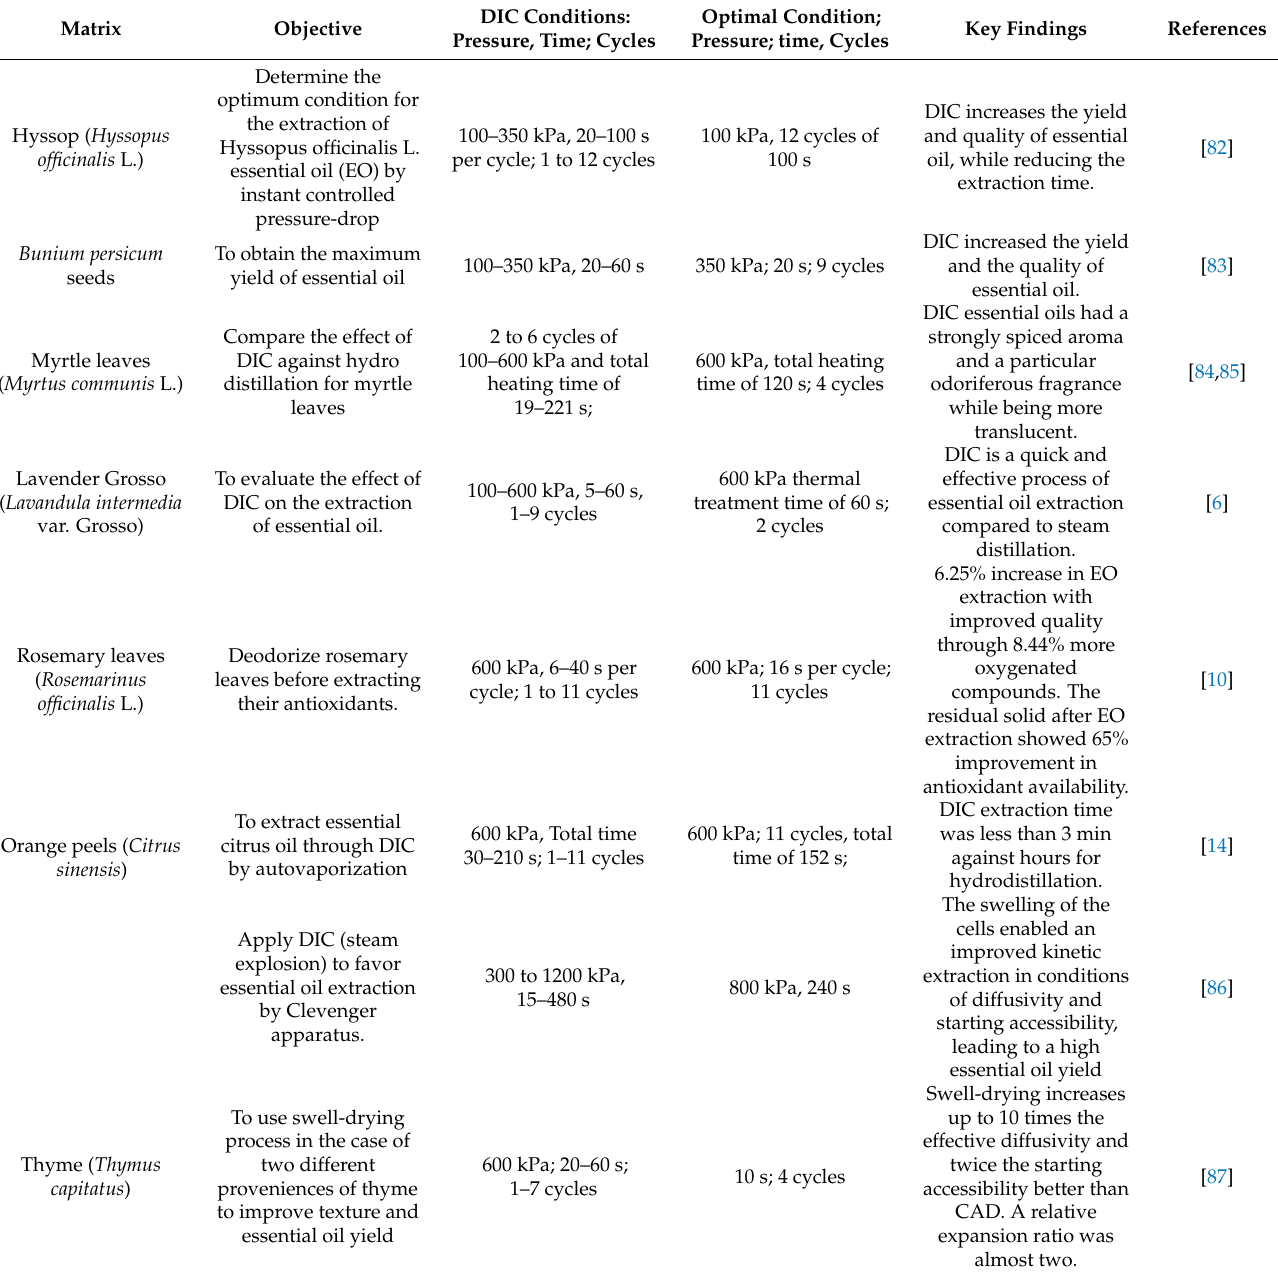
Table 6. Effect of DIC on the essential oil extraction, main conditions, and key